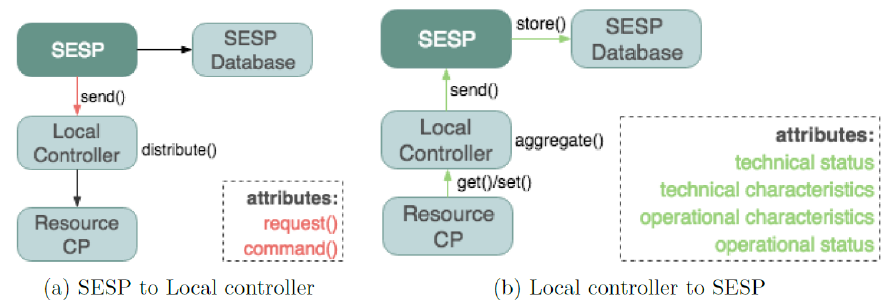
Figure 4. Sequence of PFs to exchange data between the SESP and the Local